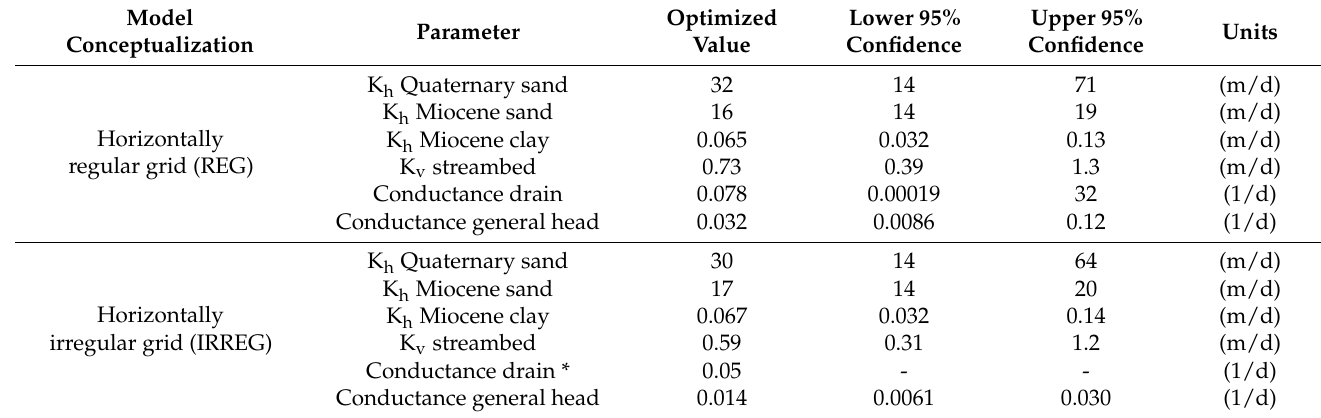
Table 1. Calibrated parameter values and their associated 95% confidence intervals.